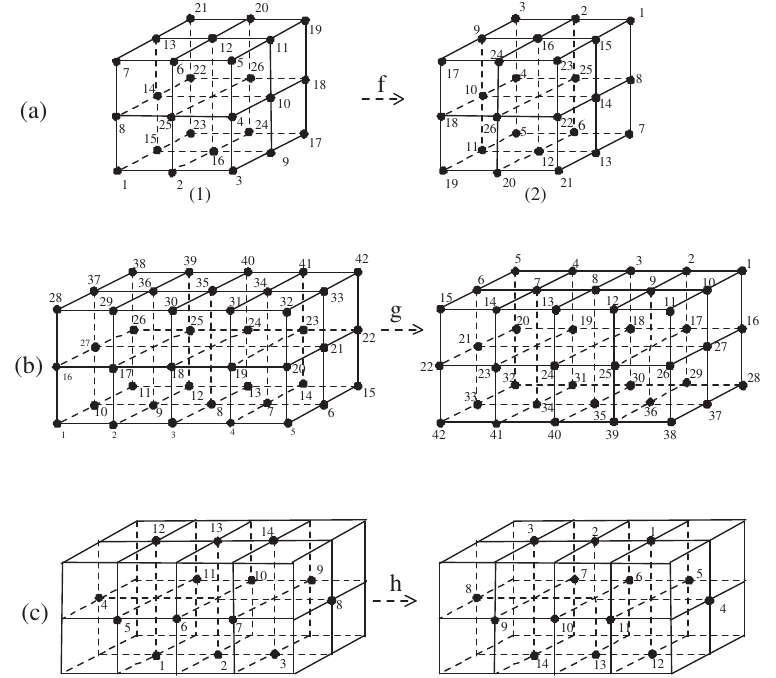
Figure 7. ( a ) Configuration of the AFPP of MSS 6 . ( b ) Configuration of the non- AFPP of C 2 MSS 6 (cid:93) MSS 6 . ( c ) In case MSS 18 (cid:93) MSS 18 (cid:54) = MSS 18 , configuration of the non- AFPP of C 2